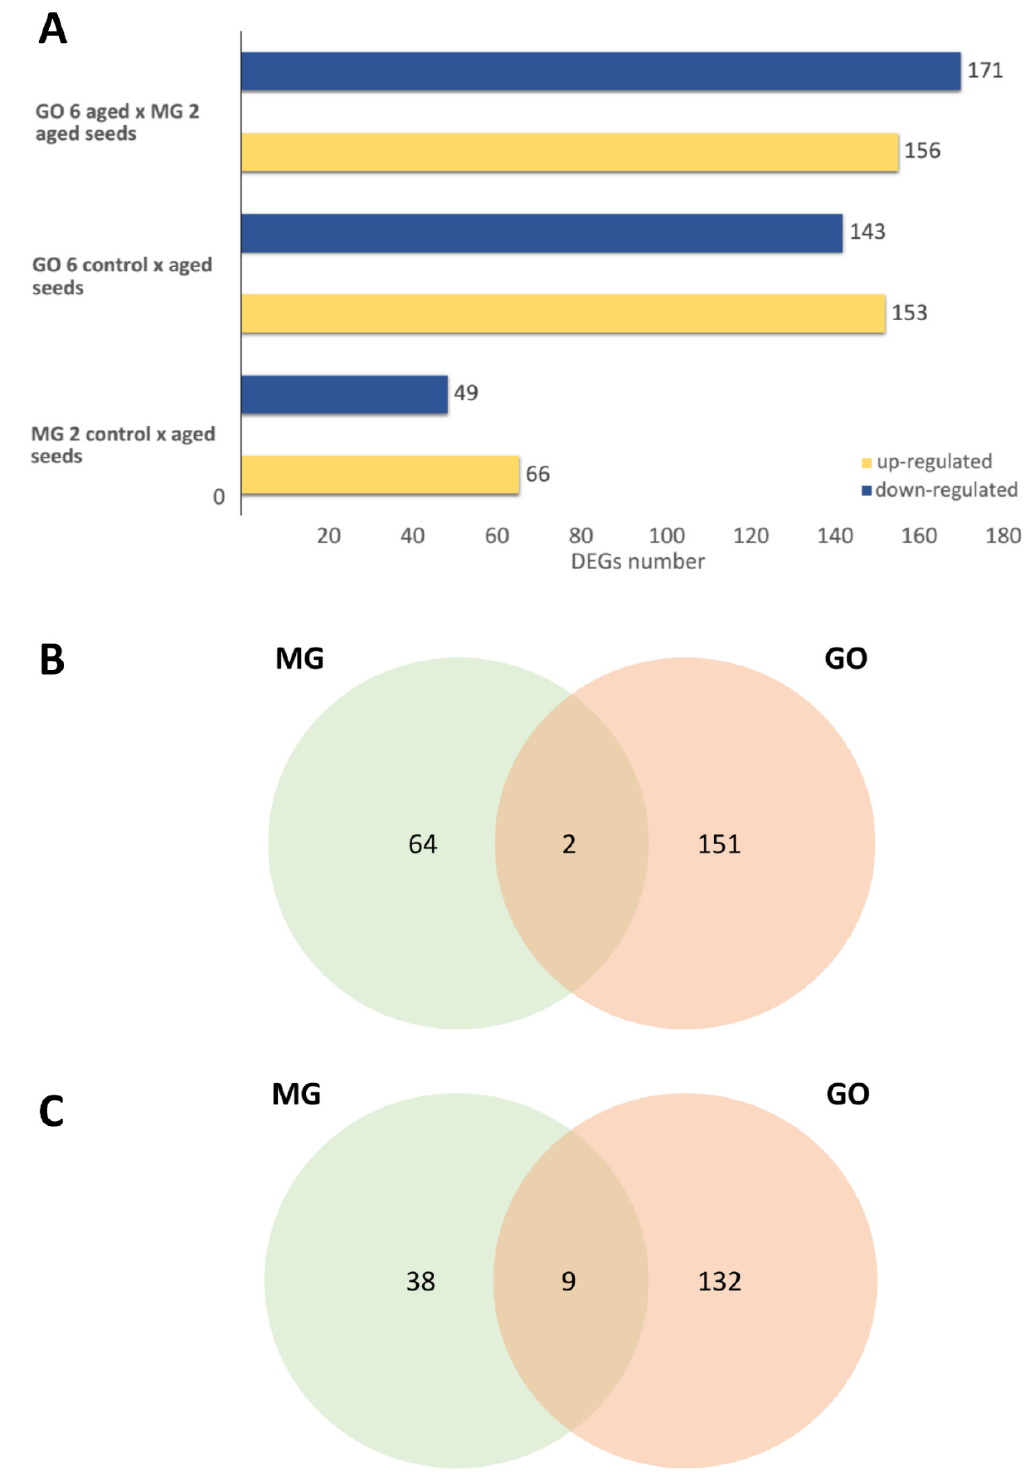
Figure 2. Statistical analysis of differentially expressed genes (DEGs) from A. fraxinifolium seed germination treatments. ( A ) Number of differentially expressed genes (DEG) in A. fraxinifolium seeds in comparison between seed treatments with and without aging (log2fold > 2, Padj ≤ 0.05). ( B ) Venn diagram of DEG upregulated between treatments of A. fraxinifolium seeds from MINAS (MG) × GOIAS (GO) accessions with aged seeds. ( C ) Venn diagram of downregulated DEG between treatments of seeds of A. fraxinifolium from accessions MINAS and GOIAS with aged seeds.